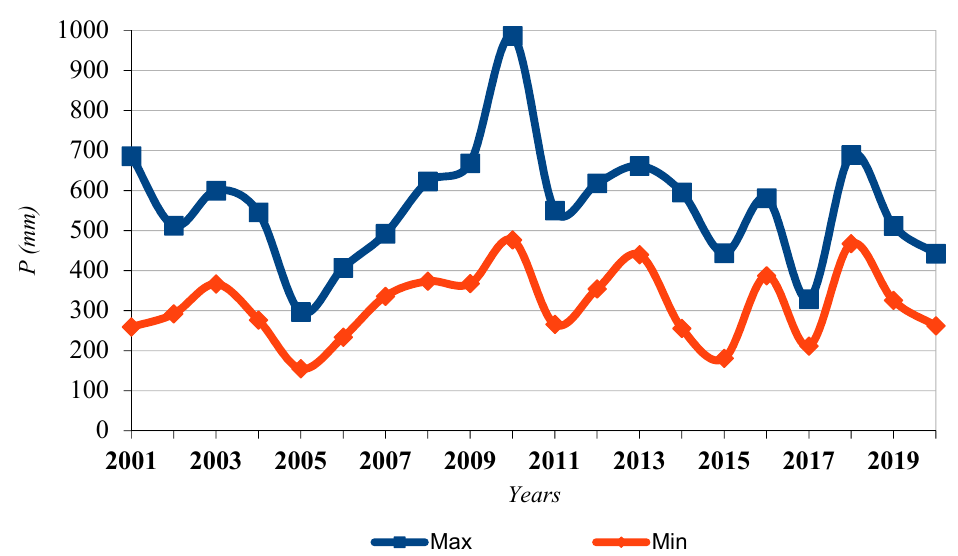
Figure 2. Maximum and minimum precipitation.